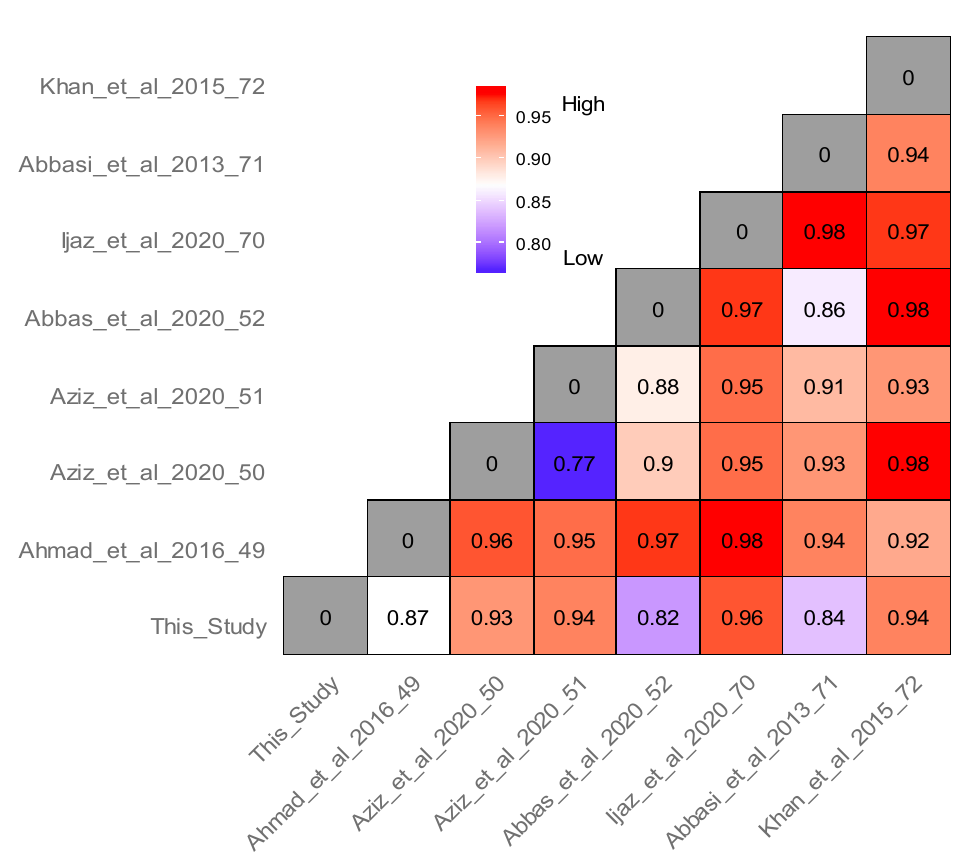
Figure 11. Pairwise Jaccard Dissimilarity Indices calculated by comparing the current study with other wild food ethnobotanical field works previously conducted in Pakistan.